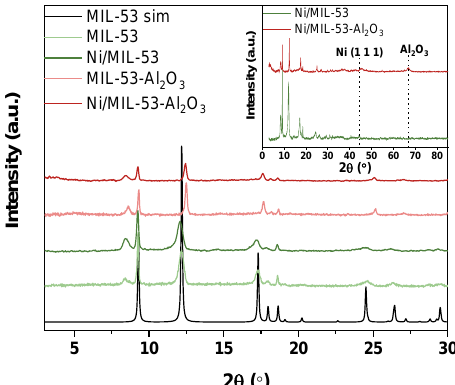
Figure 1. Low-angle XRD patterns of MIL-53 and MIL-53–Al 2 O 3 samples, and XRD patterns of the corresponding Ni-based catalysts (Ni/MIL-53, Ni/MIL-53–Al 2 O 3 ) — inset.